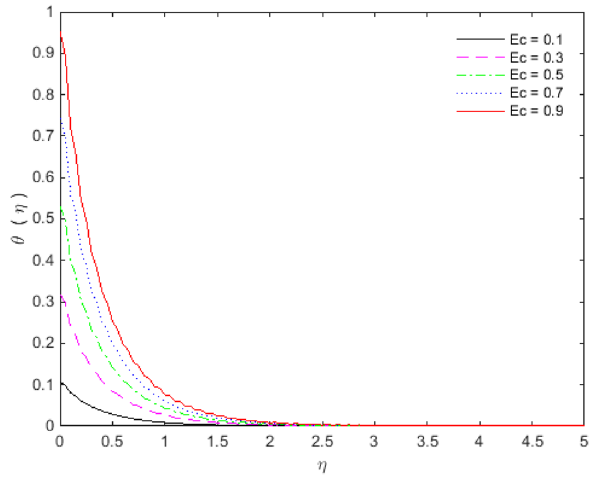
Figure 11. Temperature profile for Ec .